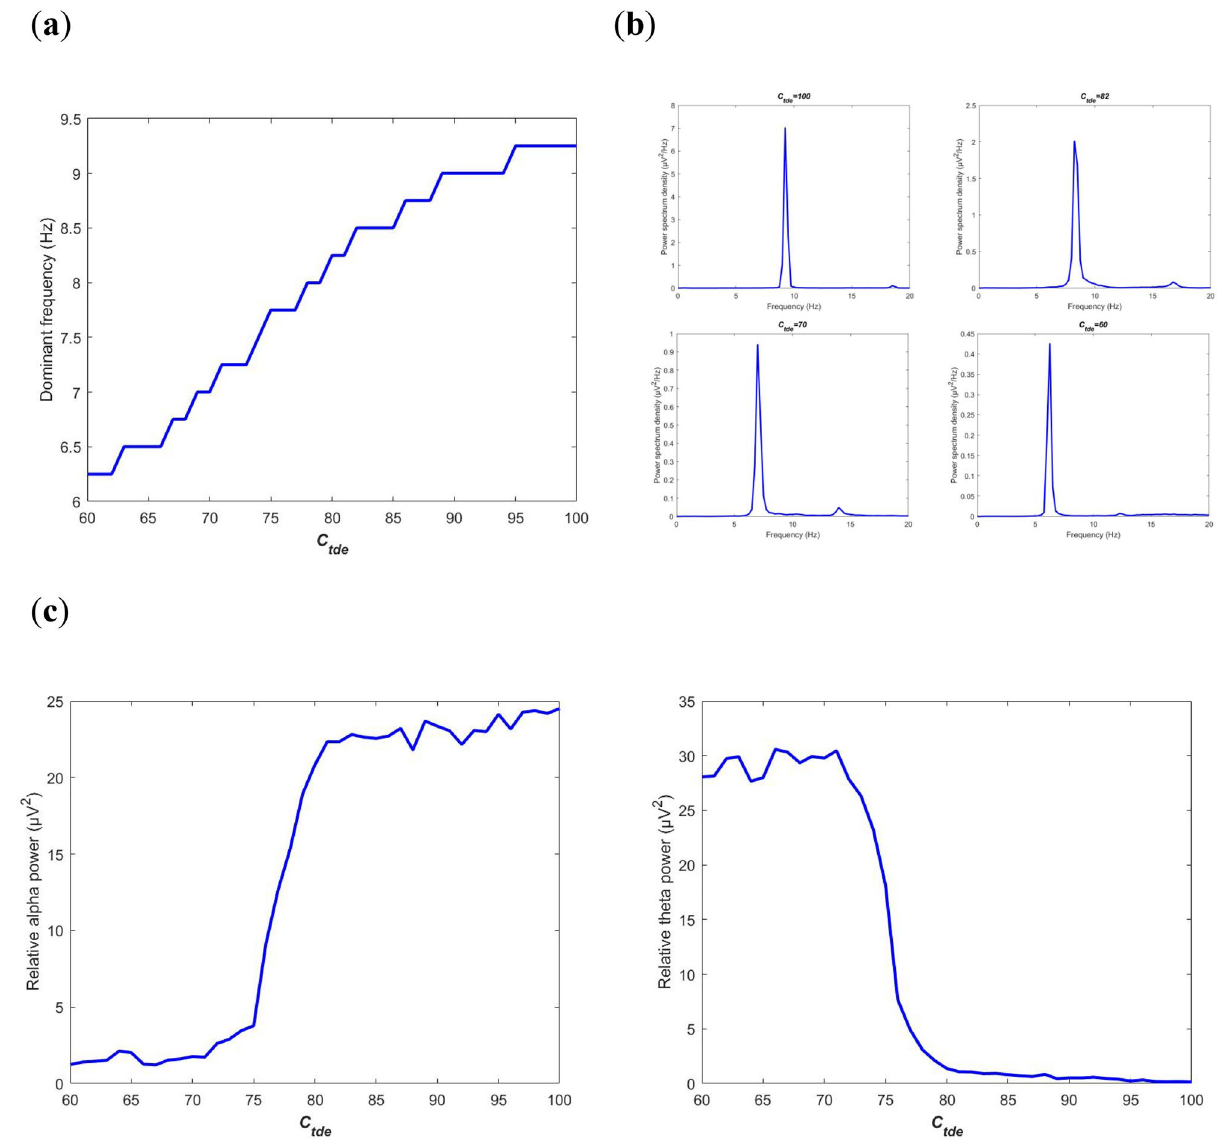
Figure 2. Power spectrum analysis of the BTC model output V t in frequency-domain when the excitatory synapse connectivity parameter C tde from PNN to TRC is varied in the range of [60, 100]. ( a ) Dependence of the dominant frequency of the model output on C tde . ( b ) Individual plots of power spectrum density when C tde takes some different values of 100, 82, 70 and 60. ( c ) The evolution of relative power in specific frequency bands: alpha frequency band (left panel) and theta frequency band (right